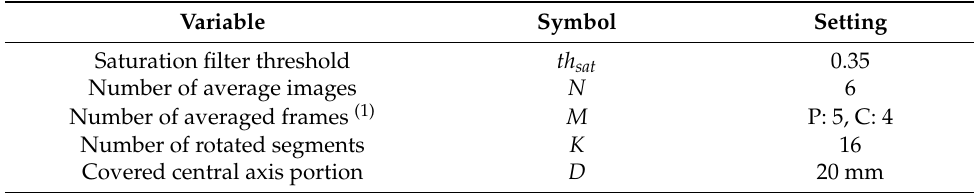
Table 6. Variables setting for both AMVS and VeMeA parameters estimation.